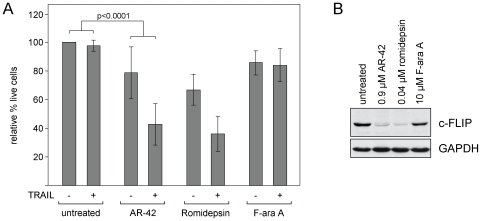
AR-42 sensitizes CLL cells to TRAIL and mediates reduction of c-FLIP.(A) CLL patient samples (n = 6) were incubated with or without AR-42 (0.90 µM) and TRAIL (100 ng/mL). Romidepsin (0.04 µM) and F-ara A (2.0 µM) were included as positive and negative controls, respectively. Cells were assessed by flow cytometry at 48 hr, and percent live (annexin and PI negative) cells were calculated relative to the time-matched untreated samples. Co-incubation with AR-42 and TRAIL produced a significant reduction in cell viability (p<0.0001) compared to TRAIL or AR-42 alone. (B) CLL cells were incubated 24 hr with or without AR-42, and lysates were analyzed for expression of c-FLIP. Romidepsin and F-ara A were included as positive and negative controls, respectively. Example is representative of seven CLL samples.